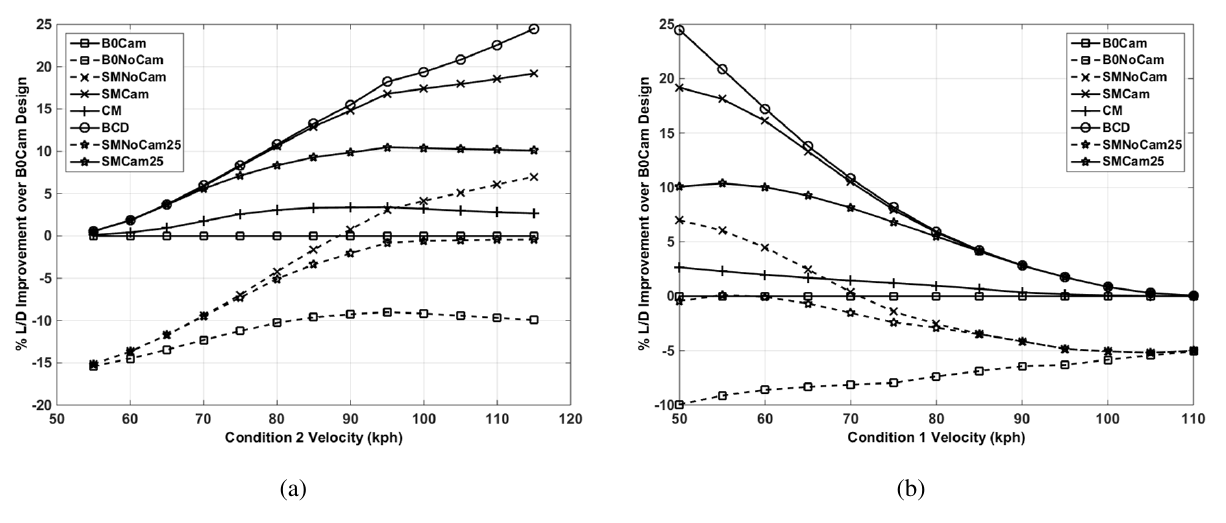
Figure 11. Aerodynamic efficiency for designs over variable speed ranges normalised to the baseline camber design. ( a ) Aerodynamic efficiency for low speed fixed at 50 kph; ( b ) aerodynamic efficiency for high speed fixed at 115